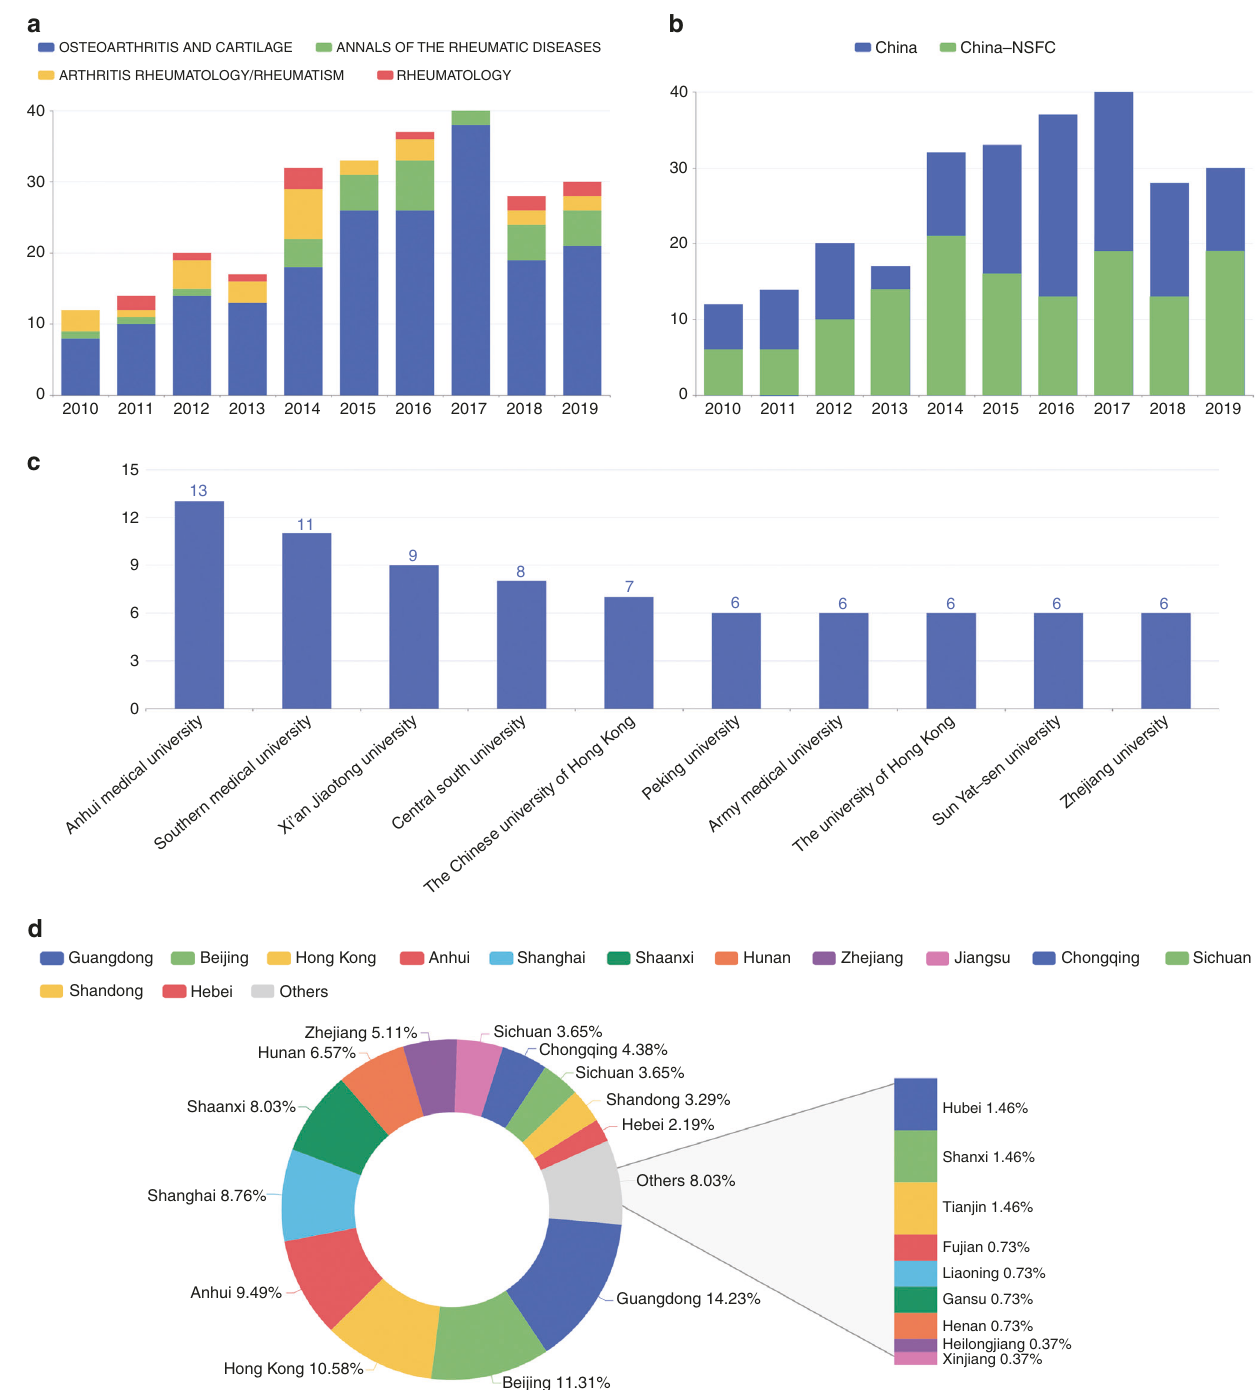
Fig. 5 Statistics for publications about China in the fi eld of OA (2010 – 2019). a Statistics on the number of papers published in four elite journals of rheumatology. b Number of Chinese studies published in elite rheumatology journals and the proportion of NSFC funding. c Statistics on the af fi liation of the corresponding authors of articles in elite rheumatology journals. d Distribution of the corresponding authors ’ af fi liations in China by